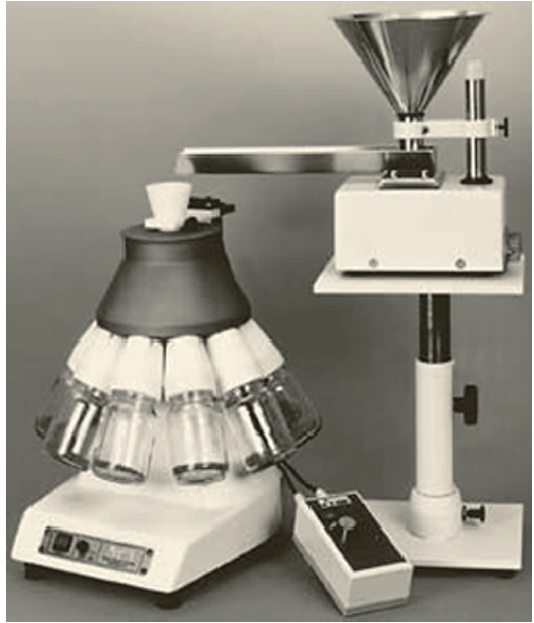
Fig. 3 A photograph of a micro Riffler. (Courtesy of Quanta- chrome Instruments, www.quantachrome.com)